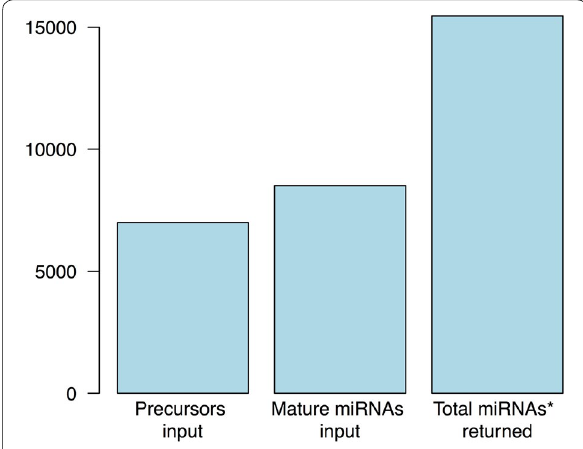
Fig. 4 Input and results of running StarSeeker on all plant data contained in miRBase. The input files contained 6992 precursors and 8496 miRNAs. The output was 15,468 miRNAs*, because some mature sequences were matched to more than one precursor due to conserved genes and miRNA families among different species